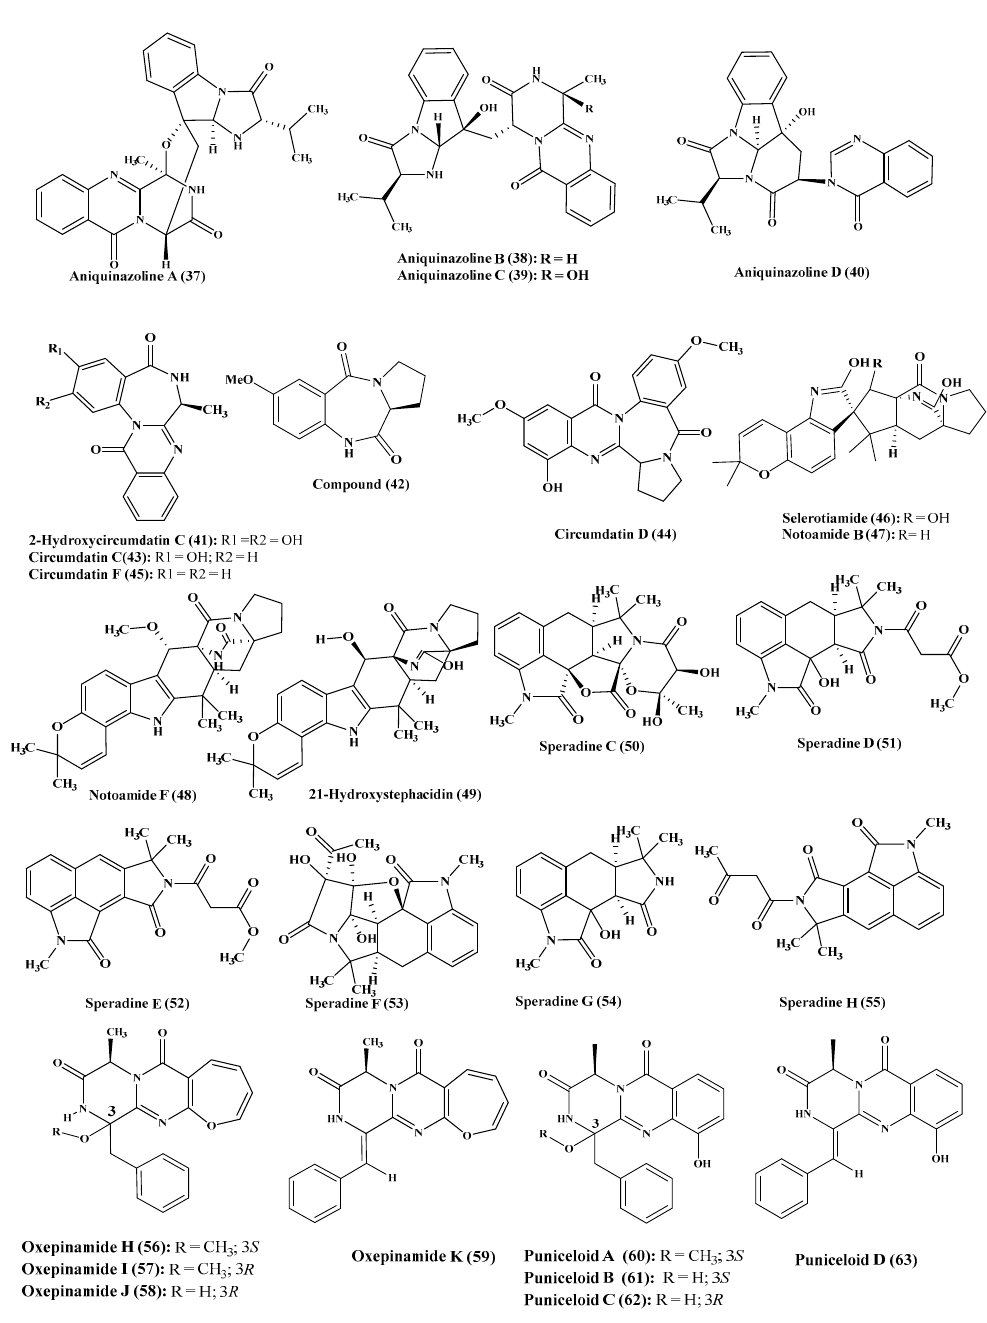
Figure 4. Alkaloids isolated from Aspergillus nidulans , A. ochraceus , A. oryzae and A. puniceus .